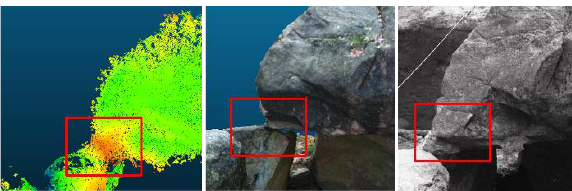
Figure 9: Cloud to mesh deviations of 25 cm (left); stone corner does not exist anymore in actual 3D model (middle); stone corner does exist in historical image (right).